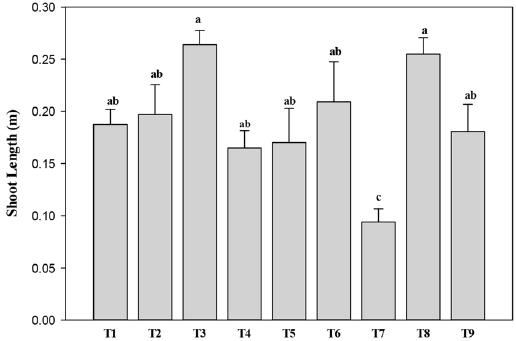
Figure 2. Shoot height of Acorus calamus was significantly influenced by polycyclic aromatic hydrocarbons (PAHs) but not by cadmium (Cd), or the interaction between the two, after 60 days of growth. Bars (mean ± SE, n = 3) with different letters are significantly different based on the least significant difference test (p ≤ 0.05). Treatments: C0P0 (T 1 ), C0P1 (T 2 ), C0P2 (T 3 ), C1P0 (T 4 ), C1P1 (T5), C1P2 (T 6 ), C2P0 (T 7 ), C2P1 (T 8 ), and C2P2 (T 9 ). C0, C1, and C2 represent 0, 10, and 20 mg Cd kg − 1 ; P0, P1, and P2 represent 0, 50 + 25, and 100 + 50 mg PAHs kg − 1 with PHN + PYR, respectively.